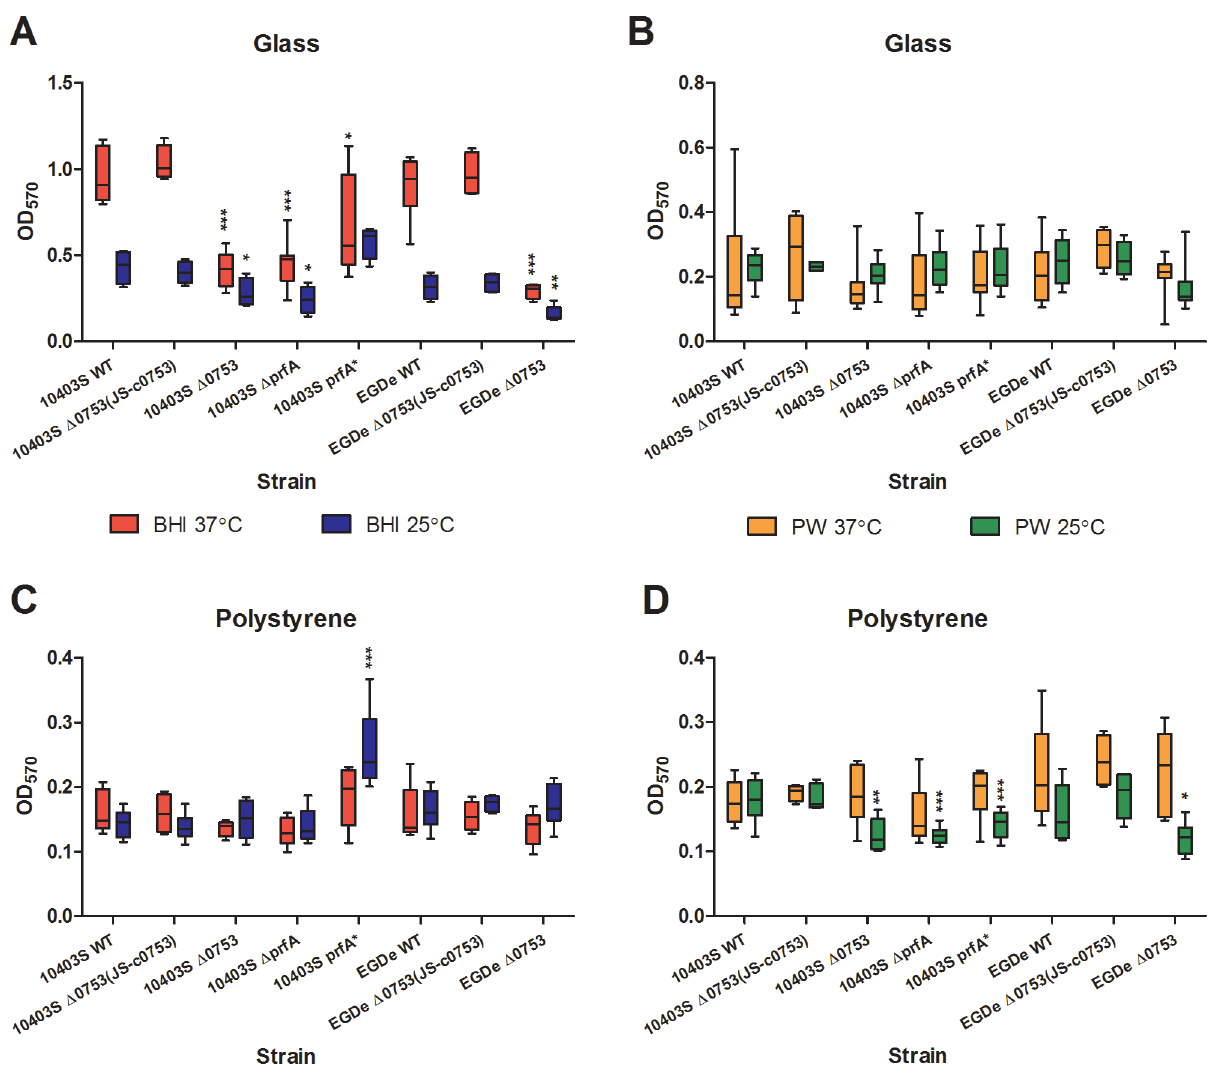
Figure 2. Biofilm production of L.monocytogenes strains. The bacterial biofilm formation is quantified by OD 570 readings. A) Quantification of biofilm formation in glass test tubes. B) Quantification of biofilm formation in polystyrene 96-well plates. Middle horizontal line in each box represents the median of the entire data set; the upper and lower horizontal lines represent the upper quadrant median and the lower quadrant median, respectively. Standard deviations represent three independent experiments. Significant differences in comparison to the parent strains under the same condition are shown as * ( P , 0.5), ** ( P , 0.001), and *** ( P , 0.0001).